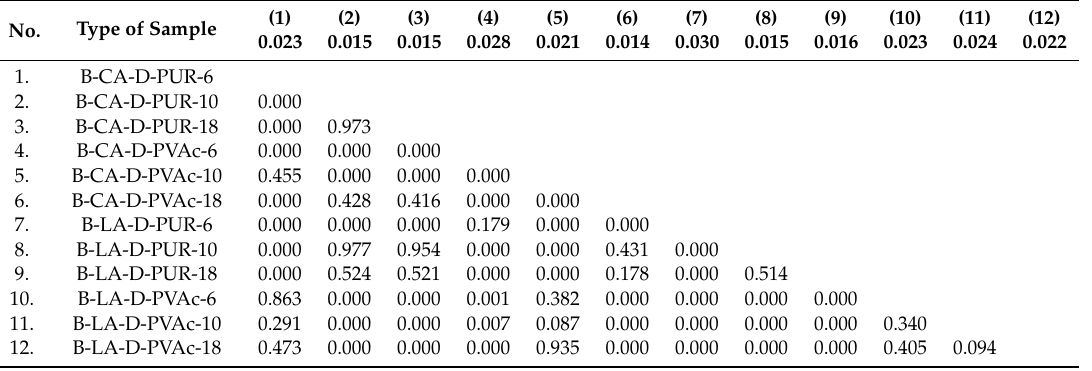
Table 25. Comparison of the e ff ects of individual factors using Duncan’s test on the coe ffi cient of bendability ( K bendB ) for beech and NWC on the